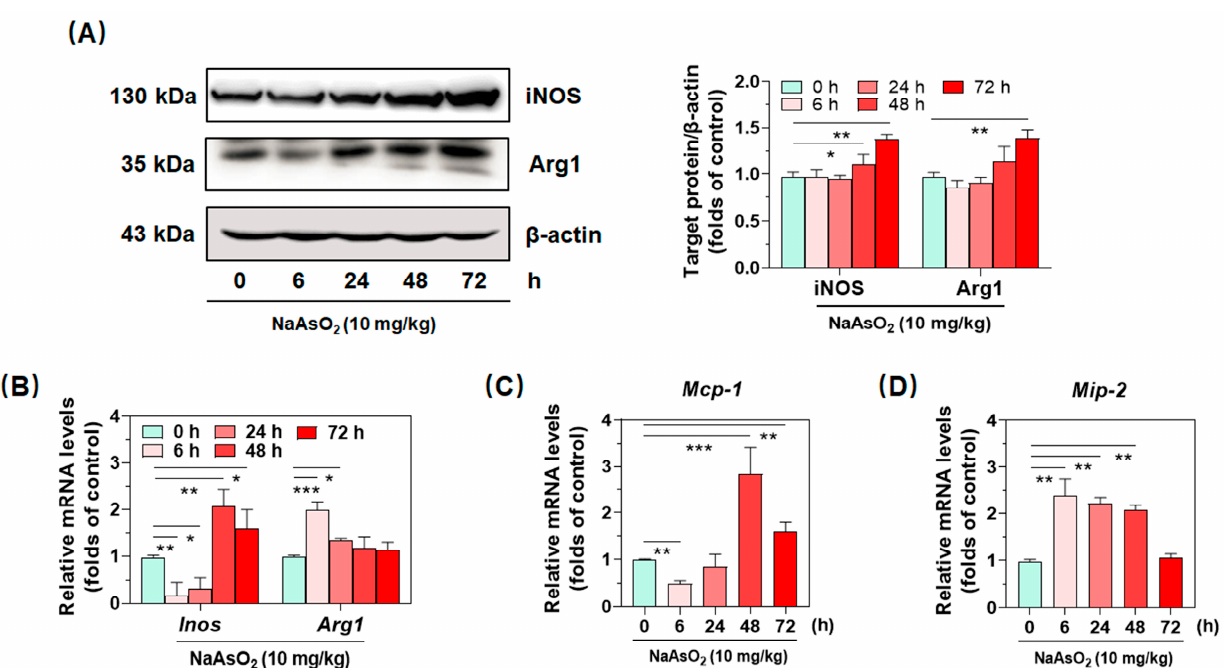
Figure 1. Up-regulated expression of macrophage phenotypic molecules and chemokines in the livers of acute arsenic-exposed mice. ( A ) hepatic protein expression of macrophage-specific phenotypic molecule iNOS and Arg1 were determined by western blotting, of which protein densities are shown, gene expression of Inos and Arg1 ( B ), as well as chemokine Mip-2 and Mcp-1 ( C , D ) were determined by real-time qPCR, of which relative mRNA levels normalized to Gapdh are shown at different time points after an oral administration of NaAsO 2 . Data are presented as mean ± SD ( n = 4). * denotes p < 0.05 compared with the control group. ** denoted p < 0.01 compared with the control group. *** denotes p < 0.001 compared with the control group.